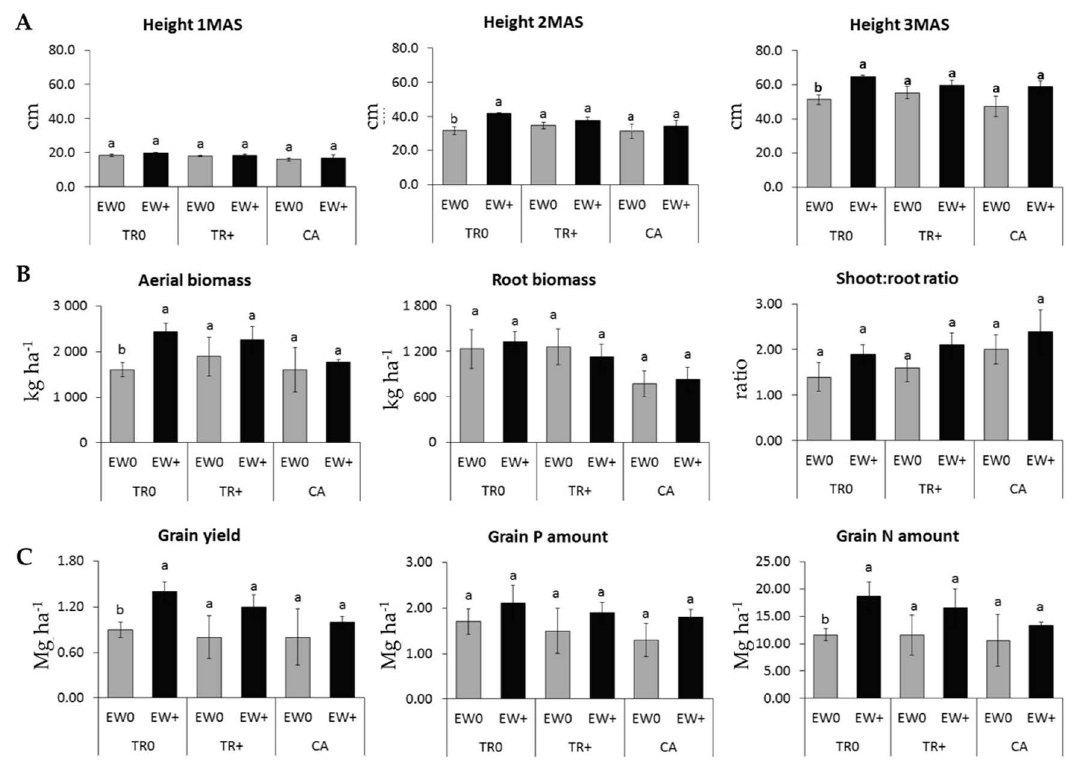
Figure 3. Plant properties at the 3rd cropping season according to treatments (earthworm inoculation, cropping system). Error bars indicate standard errors. Letters indicate significant differences between EW0 and EW+ for different cropping systems according to Student t-test. ( A ) Plant height, ( B ) Plant biomass, ( C ) Plant production and nutrition. Legend: see Figure 1. MAS = month after sowing.